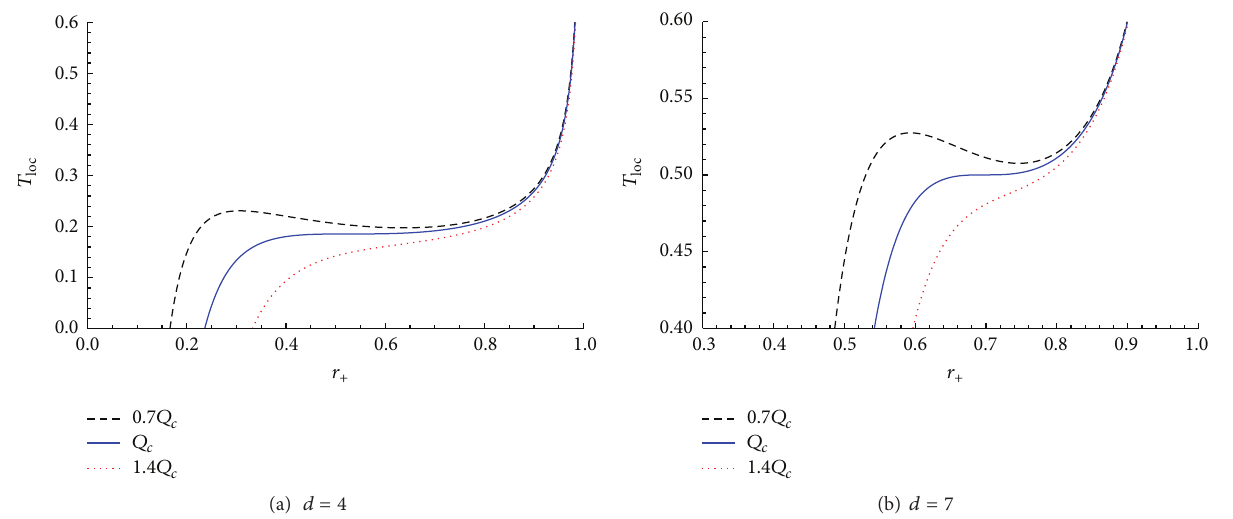
Figure 1: The 𝑇 loc - 𝑟 + curves for 𝑑 = 4, 7 , respectively. From top to bottom the curves correspond to the charges 0.7𝑄 𝑐 , 𝑄 𝑐 , and 1.4𝑄 𝑐 .